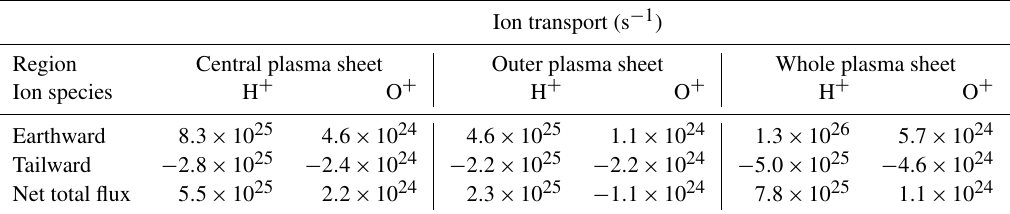
Table 1. Summary of calculated total H + and O + transports (s − 1 ) in the near-Earth plasma sheet ( − 20 < X GSM < − 10 R E ). The transports are given separately for earthward, tailward flows, and the corresponding net fluxes, for the central plasma sheet, outer plasma sheet, and the whole plasma sheet.